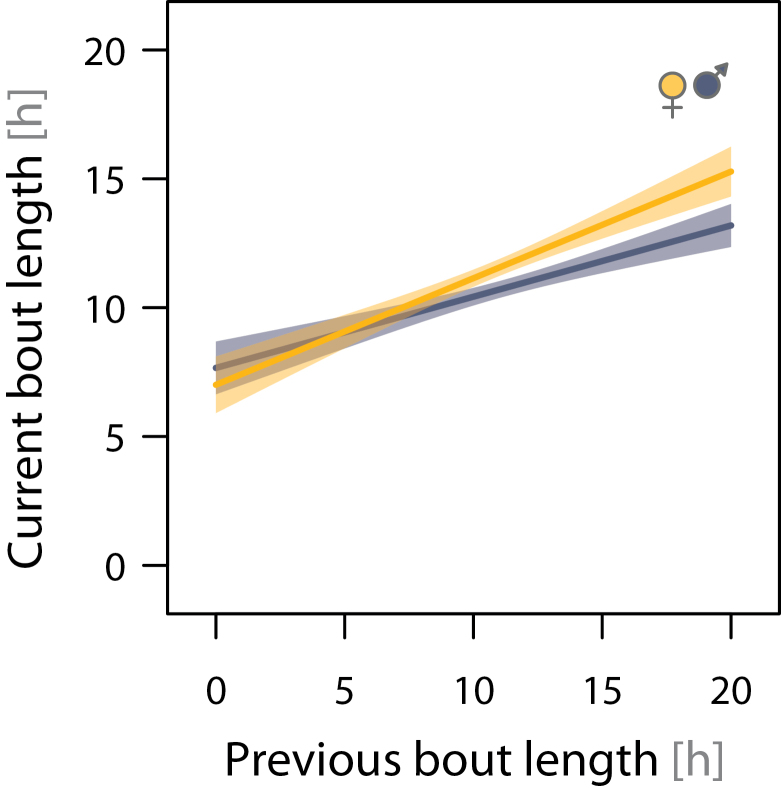
Positive relationship between incubation bout length and previous bout length (partner’s bout; off-nest bout of the focal bird). The solid lines represent the model fit, and the shading represents the 95% CI. Model results are presented in Table 3.